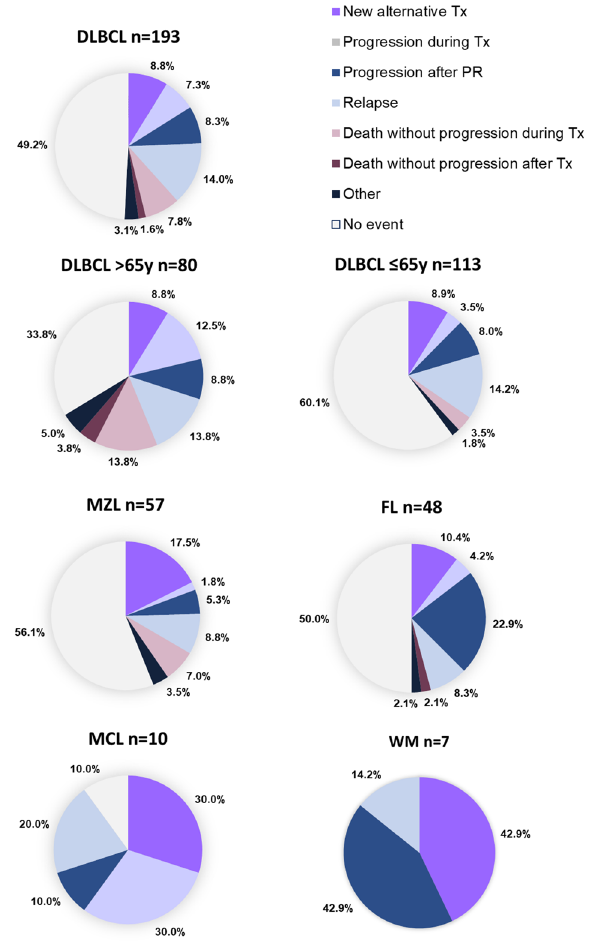
Figure 3. Treatment events after 1st-line treatment using standard regimens in patients with B-NHL (N = 366). DLBCL, diffuse large B-cell lymphoma; FL, follicular lymphoma; MCL, mantle cell lymphoma; MZL, marginal zone lymphoma; WM, Waldenström’s macroglobulinemia or lymphoplasmacytic lymphoma; Tx, treatment; PR, partial response. *1st-line = R-CHOP like/CHOP or R-COP/COP in patients with DLBCL; R-CHOP-like or R-COP/COP in patients with FL; all administered treatments for other